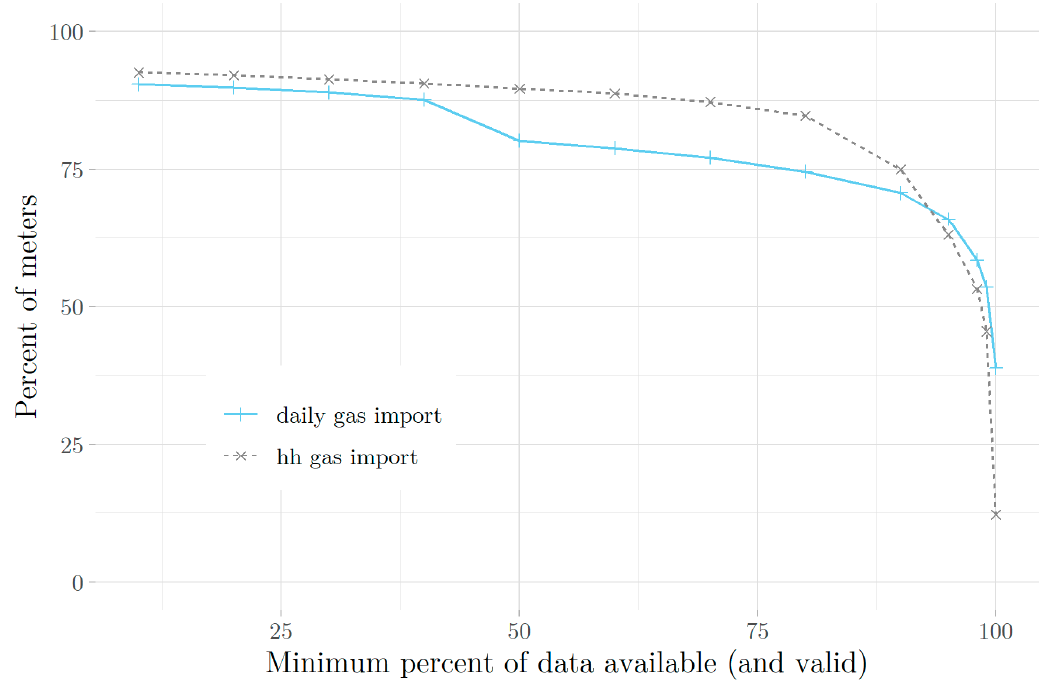
Figure 6. Percent of meters with x% of data valid over their potential valid read date range, by type of gas read (daily and half-hourly (‘hh’)).